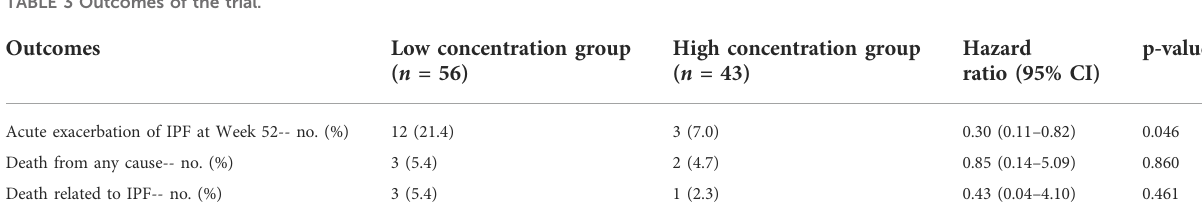
High concentration group ( n = 43)